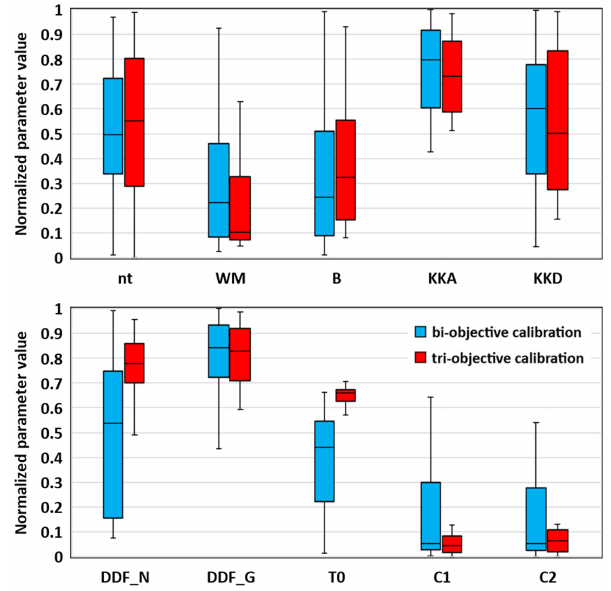
Figure 3. Uncertainties of the behavioral parameter set obtained by bi- and tri-objective calibration methods for BM_YTR scenario in the YTR basin.